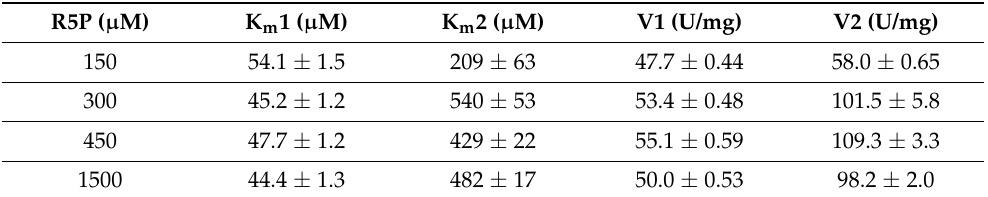
Table 3. Kinetic parameters of holoTK in two-substrate reaction for X5P binding with different concentrations of R5P.